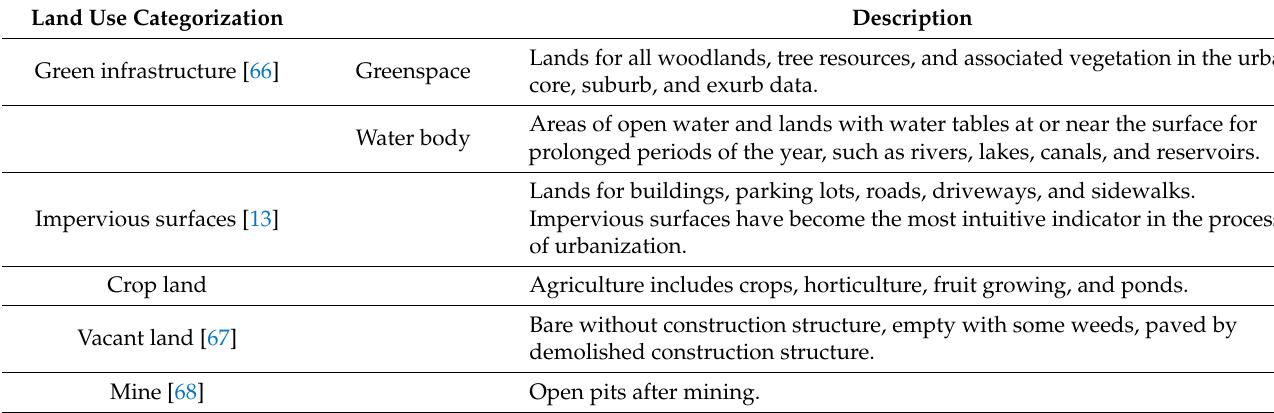
Table 2. The classification and description of the land cover